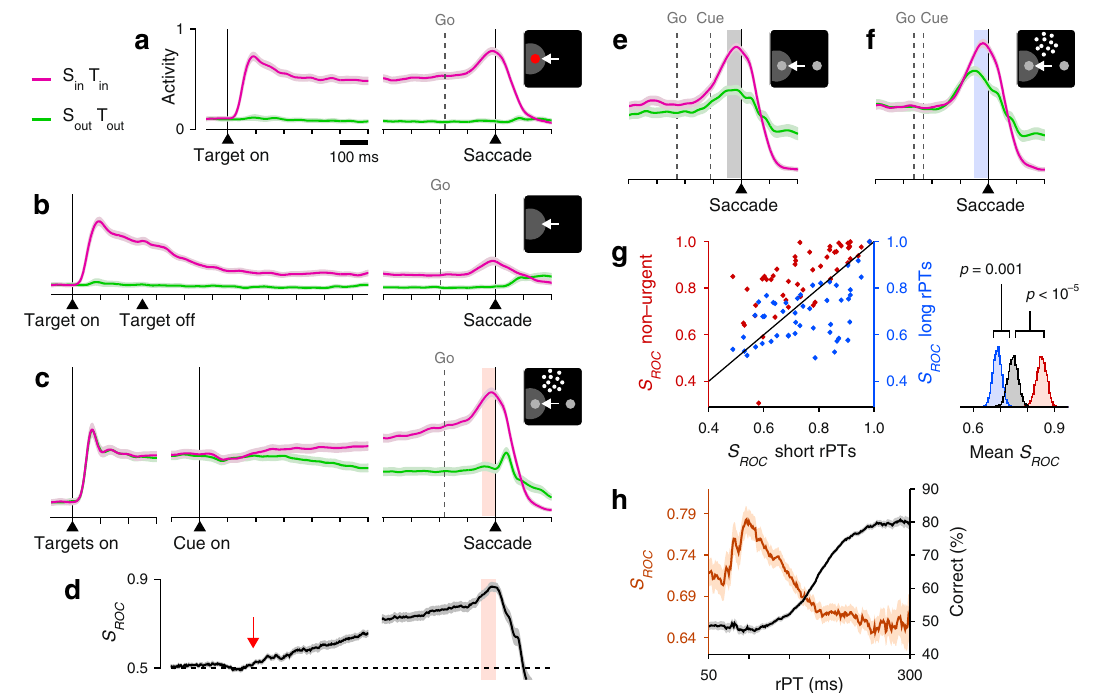
Fig. 2 | LIP activity in urgent versus non-urgent random-dot motion dis- crimination. a Responses during visually guided saccades. Traces show normal- ized fi ring rate (mean±1 SE across cells; n =50) as a function of time for correct trials into (magenta) or away from the cell ’ s RF (green). Same axes for panels b , c , e , f . The gray dotted line indicates the median onset of the go signal. b Responses during memory-guided saccades ( n =49). c Responses in the non- urgent RDM task ( n =51). d Spatial signal magnitude (mean±1 SE) as a function of time for the data in c (same time axis). Throughout the article, S ROC measures the statisticalseparationbetweeninwardandoutwardresponses(Methods).Redarrow marksapproximateonsetofdifferentiation(190ms). e ResponsesintheCRDMtask ( n =51) during guesses (rPT ≤ 150 ms). f Responses in the CRDM task during fully